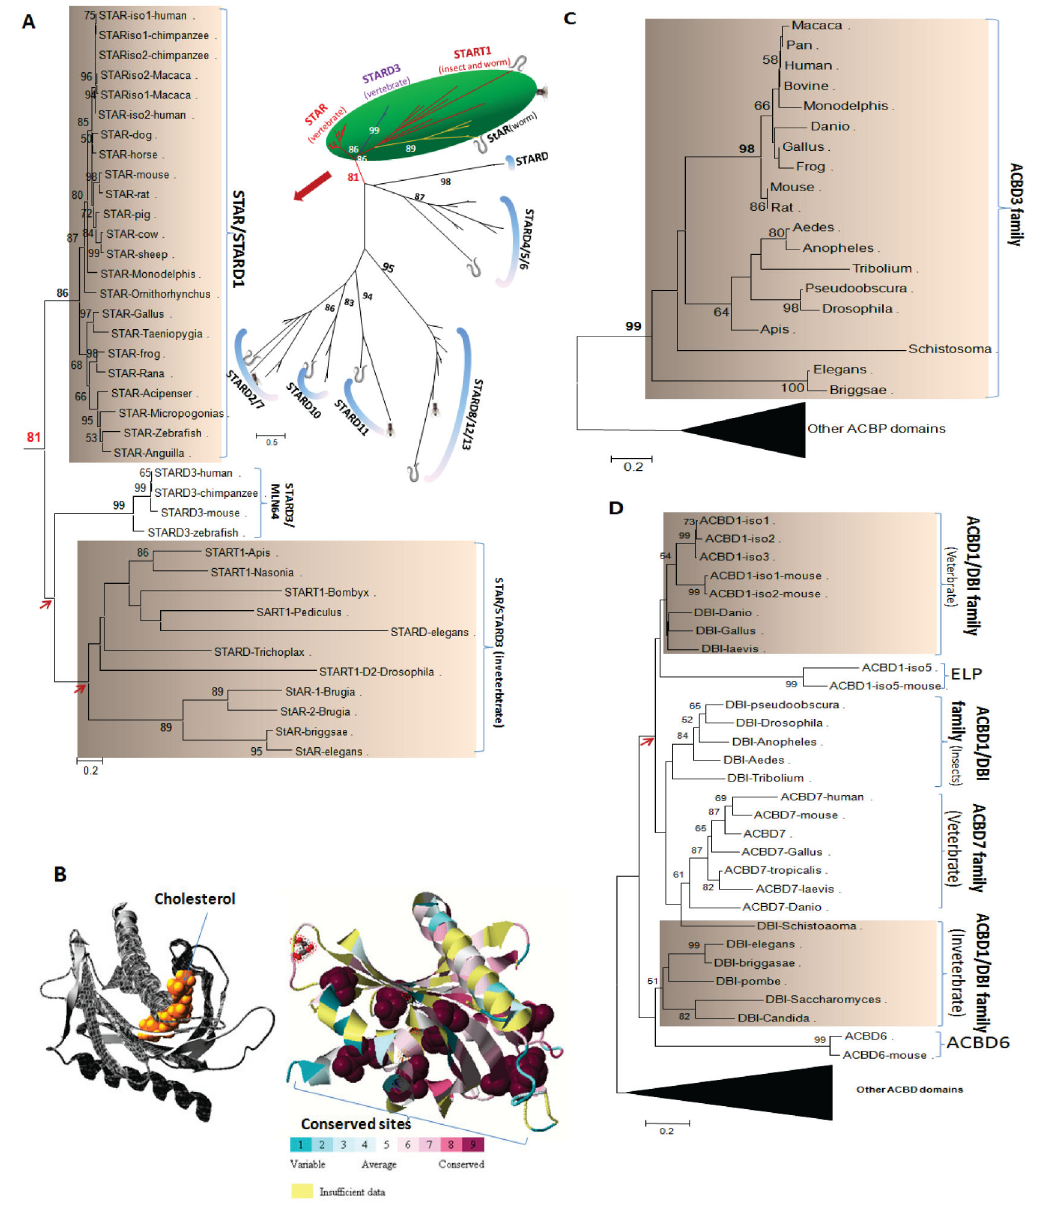
Figure 3. Conserved elements in steroidogenesis machinery involved in cholesterol transport from humans to worms. A. NJ tree for the START family. The orthologous genes of human STAR can be traced back to C. elegans . B. Homology modeling of the mouse STAR (left) and the evolutionary conservation profiles of the START family (right). The evolutionary conservation profiles are mapped on the homology 3-D ribbon model of mouse STAR, where the most conserved (score 9) residues are displayed by space-filled atoms. The amino acid residues are colored according to their conservation grades using the color-coding bar, with turquoise through maroon indicating variable through conserved, respectively [33]. C. NJ tree for the ACBD3 (PAP7) family. The orthologous genes of human ACBD3 form a unique branch and are highly conserved within animals (adapted from ACBD3 review [4]). D. NJ tree for the ACBD1/DBI family. The orthologous genes of human ACBD1 are limited within vertebrates but exhibit